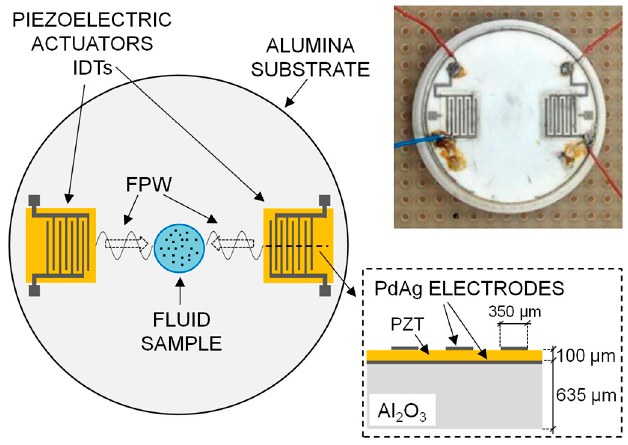
Figure 1. Sketch and picture of the fabricated device with a cross section of the actuators. Poling was done along the thickness using the bottom